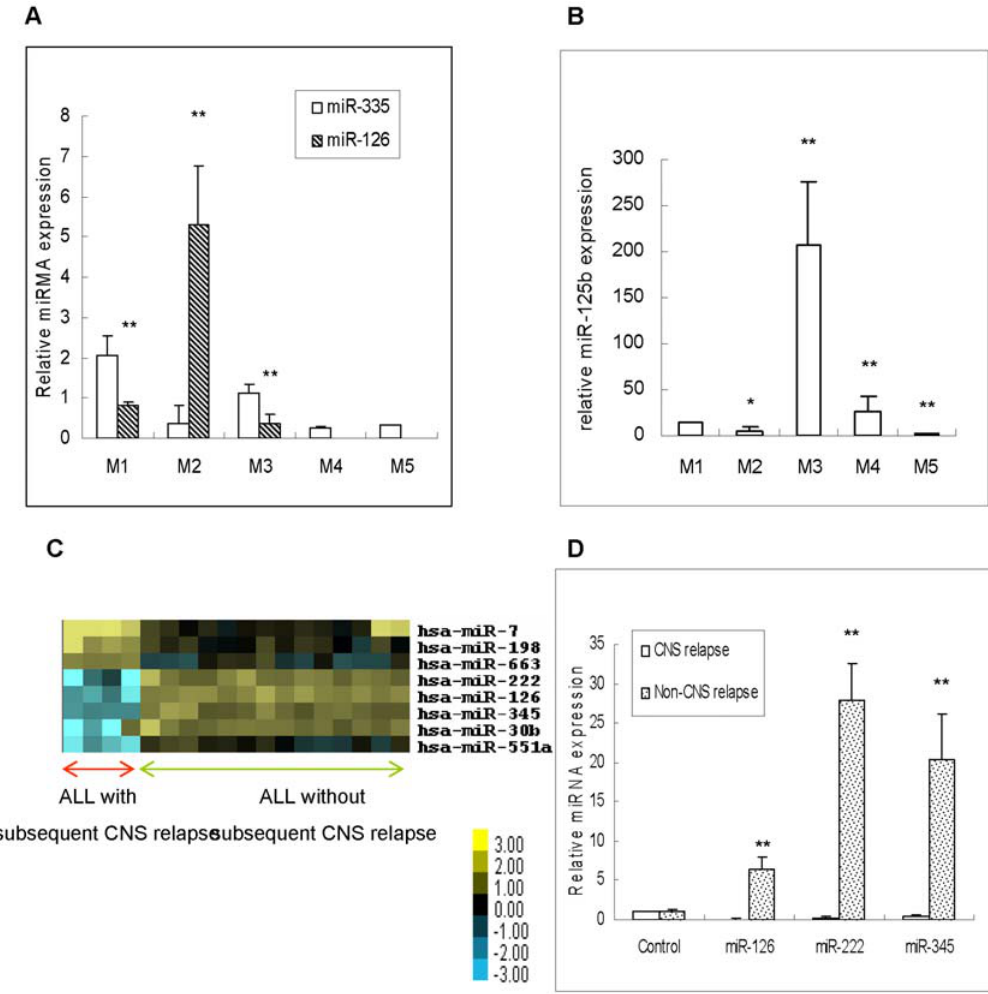
Figure 2. MiRNA expressions in AML subtypes were validated with qRT-PCR using the validation cohort and miRNA expression pattern associated with CNS relapse. (A) MiR-335 and miR-126 expressions in AML subtypes using the validation cohort (the p values for miR-126 were p=0.006 in M1, p=0.000 in M2 and p=0.000 in M3, respectively); (B) MiR-125b expression in AML subtypes using the validation cohort (the p values for miR-125 were p=0.037 in M2, p=0.000 in M3, p=0.000 in M4 and p=0.002 in M5, respectively); (C) MiRNA expression pattern of pediatric ALL associated with or without CNS relapse; (D) MiR-126 (p=0.005), miR-222 (p=0.000) and miR-345 (p=0.000) were confirmed down-regulated in pediatric ALL patients with CNS relapse compared with non-CNS relapse using the validation